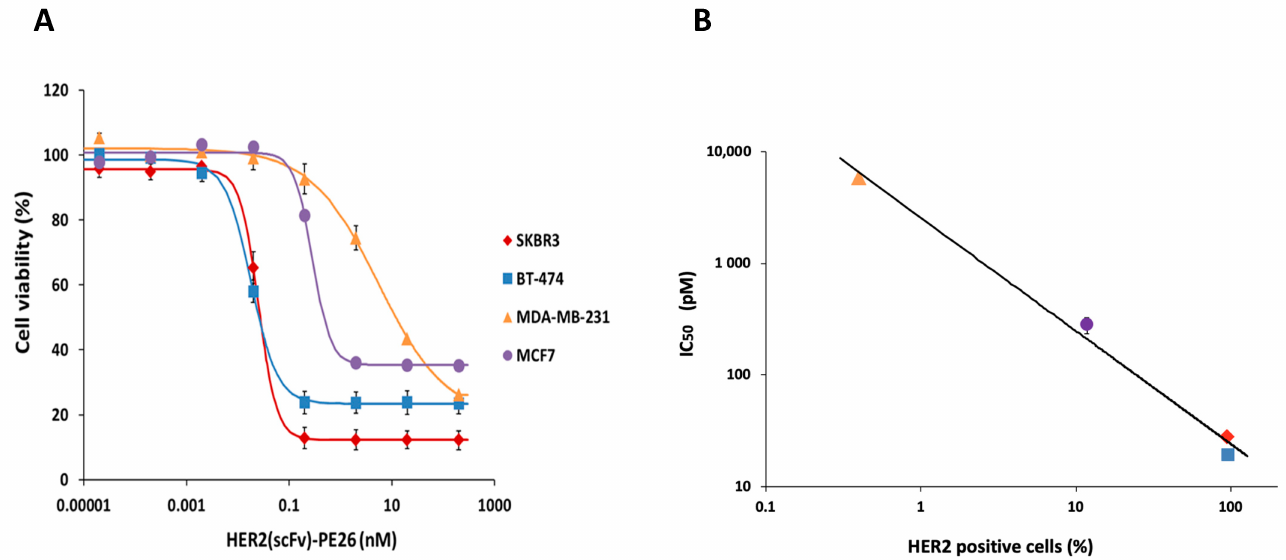
Figure 8. Correlation of the cytotoxicity of HER2(scFv)-PE24B and the HER2-positive percentage of cell lines. ( A ) The cytotoxicity of HER2(scFv)-PE24B against each of the four cell lines plotted together. Data are presented as mean error (SE). ( B ) IC 50 values for HER2(scFv)-PE24B and HER2 expression show a strong negative correlation. As the percentage of HER2-positive cells increases, the IC 50 of HER2(scFv)-PE24B decreases. The data were fitted using the power function: IC 50 = 2561.2 (percentage of HER2-positive cells) − 1.023 with an R 2 value of 0.9917. The key shows the symbols × corresponding to MDA-MB-231, MCF7, SKBR3, and